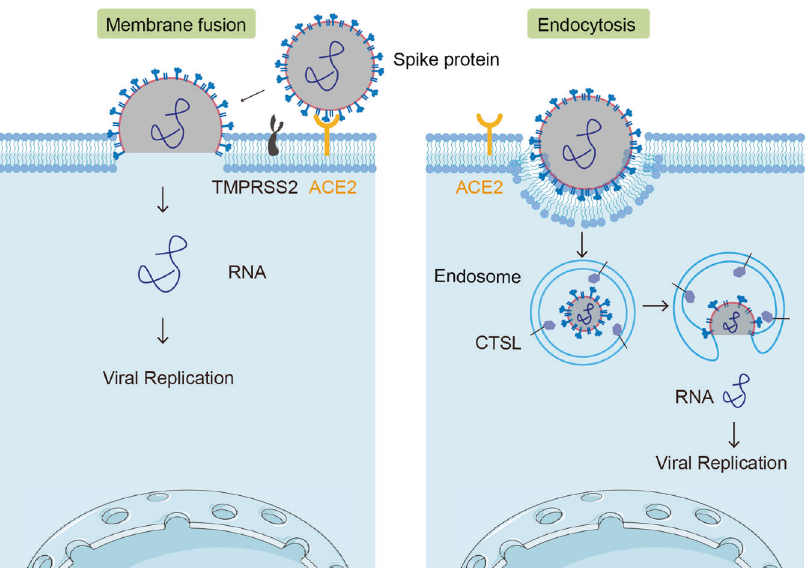
Fig. 1 SARS-CoV-2 invades cells via two distinct pathways. Viral entry can be mediated by membrane fusion or endocytosis. The former involves binding of the SARS-CoV-2 S protein to the ACE2 receptor enriched in host cells and cleavage by the cell membrane enzymes furin and TMPRSS2. S protein cleavage exposes hydrophobic amino acid residues, triggering fusion of the proximal viral and plasma membranes, and the viral RNA is released into the cytoplasm. In the endocytosis route, viral particles are enclosed in the endosome following uptake. With gradual acidi fi cation of the endosomes by v-ATPase recruitment, CSTL activity is recovered to cleave the S protein, leading to fusion of the viral and endosomal membranes and subsequent release of the viral RNA into the cytoplasm. In host cells expressing low levels of TMPRSS2 or macrophages, the endocytosis pathway of SARS-CoV-2 uptake may be